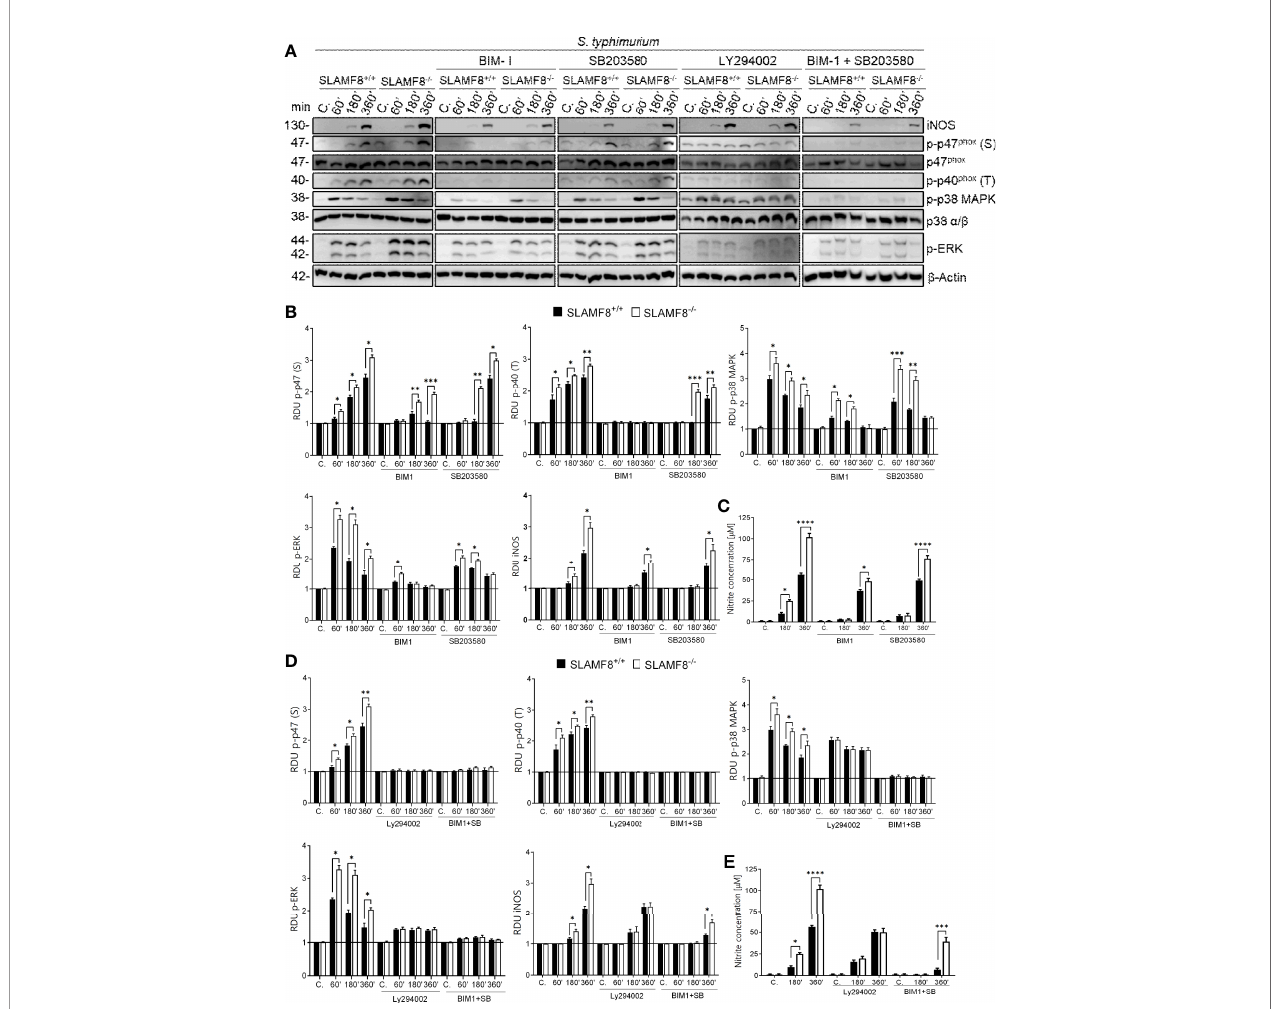
FIGURE 5 | Analyses of activation of NOX2 subunits, ERK1/2, and p38 MAPK in SLAMF8 +/+ and SLAMF8 - /- pMø upon infection in vitro with S. typhimurium , and determination of NO production. pMø were pretreated with or without 5 µM bisindolylmaleimide I (BIM1), 10 µM SB203580 (SB), or 10 µM LY294002 (Ly) for 1 h, and then infected with S. typhimurium (MOI 10) at different chase times. (A) Representative Western blots of indicated protein lysates. Results of one out of three independent experiments are shown. (B, D) Relative expression of phosphorylated proteins indicated in A; levels were normalized to appropriate loading controls and are graphically represented. *Indicates differences between SLAMF8 +/+ vs. SLAMF8 -/- cells at each time point, * p < 0.05; ** p < 0.01, *** p < 0.001. (C, E) Analysis of NO production in SLAMF8 +/+ and SLAMF8 - /- pMø infected with S. typhimurium. Histogram shows nitrite concentration [ m M] as determined by the Griess reaction. Values indicate mean ± SEM. *Indicates differences between SLAMF8 +/+ vs. SLAMF8 -/- cells at each time point, * p < 0.05; *** p < 0.001; **** p <0.0001. C, control; RDU, relative densitometry units; S, Serine; T,